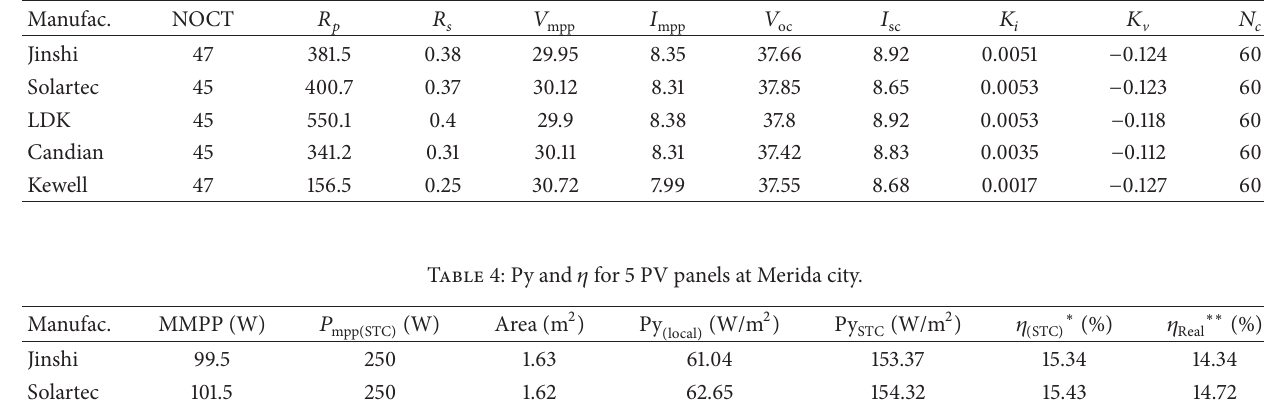
Table 3: Results of three first steps in Merida city.